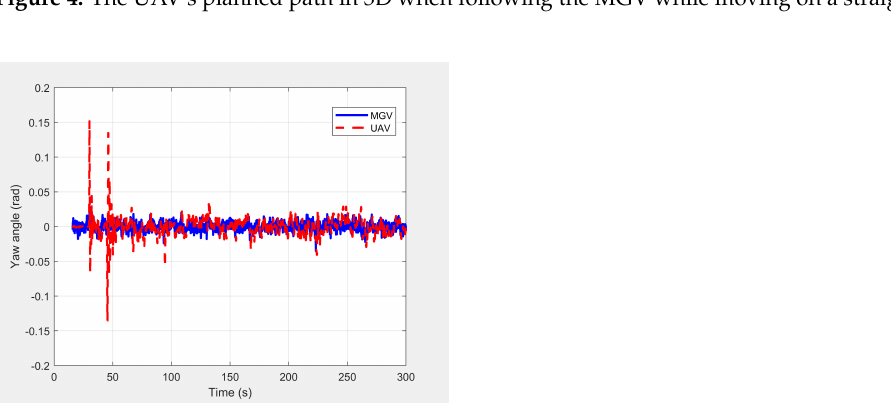
Figure 4. The UAV’s planned path in 3D when following the MGV while moving on a straight path.